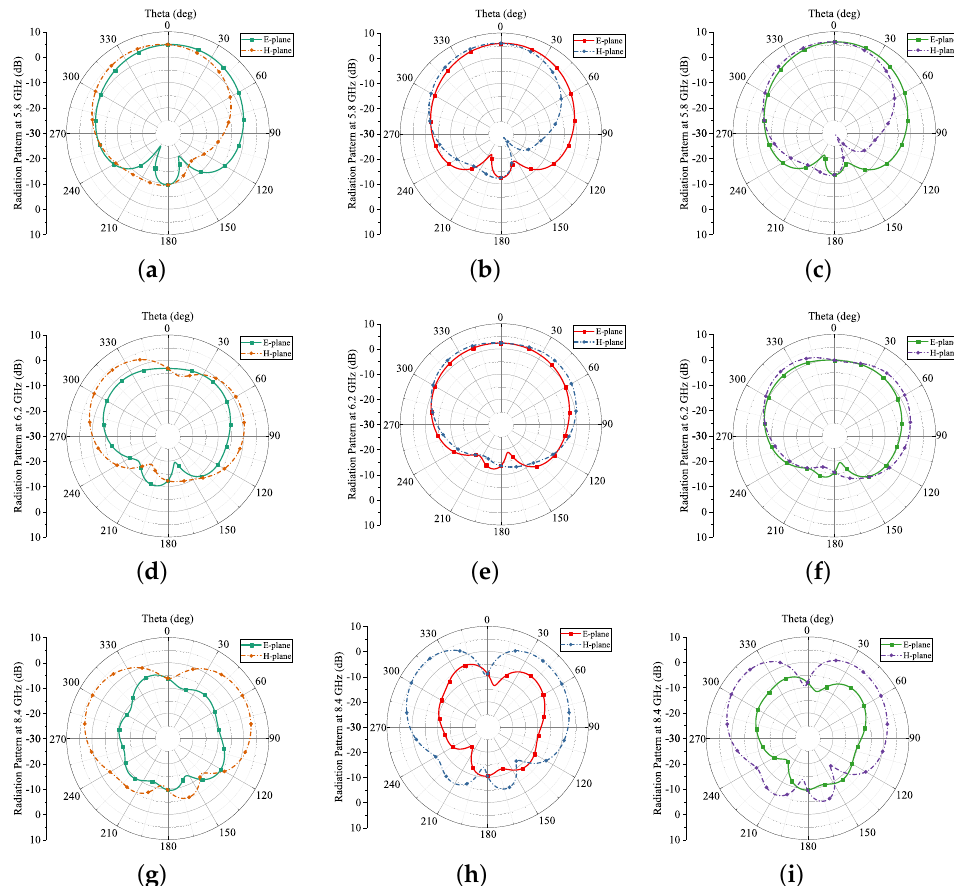
Figure 15. Simulated E-plane and H-plane for conformal tests. ( a ) E, H-plane at 5.8 GHz for 20 mm; ( b ) E- and H-plane at 5.8 GHz for 50 mm; ( c ) E- and H-plane at 5.8 GHz for 80 mm; ( d ) E- and H-plane at 6.2 GHz for 20 mm; ( e ) E- and H-plane at 6.2 GHz for 50 mm; ( f ) E- and H-plane at 6.2 GHz for 80 mm; ( g ) E- and H-plane at 8.4 GHz for 20 mm; ( h ) E- and H-plane at 8.4 GHz for 50 mm; and ( i ) E- and H-plane at 8.4 GHz for 80